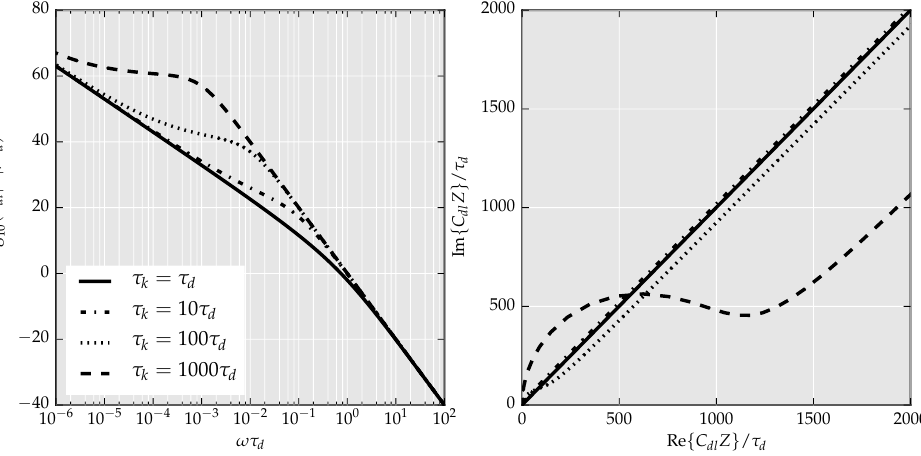
Figure 6. Bode (left) and Nyquist (right) plots for WE impedance Z . R Ω = 0 in all